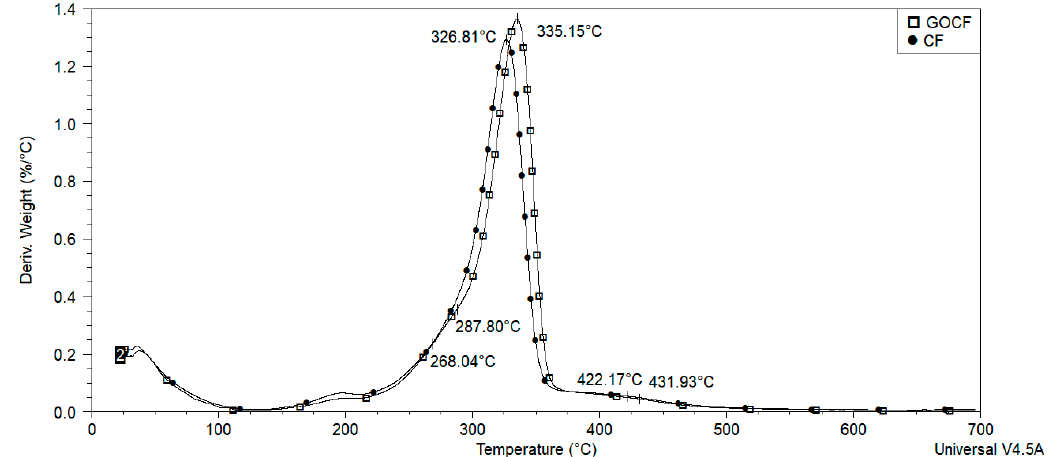
Figure 7. DTA curves of CF and GOCF fibers.